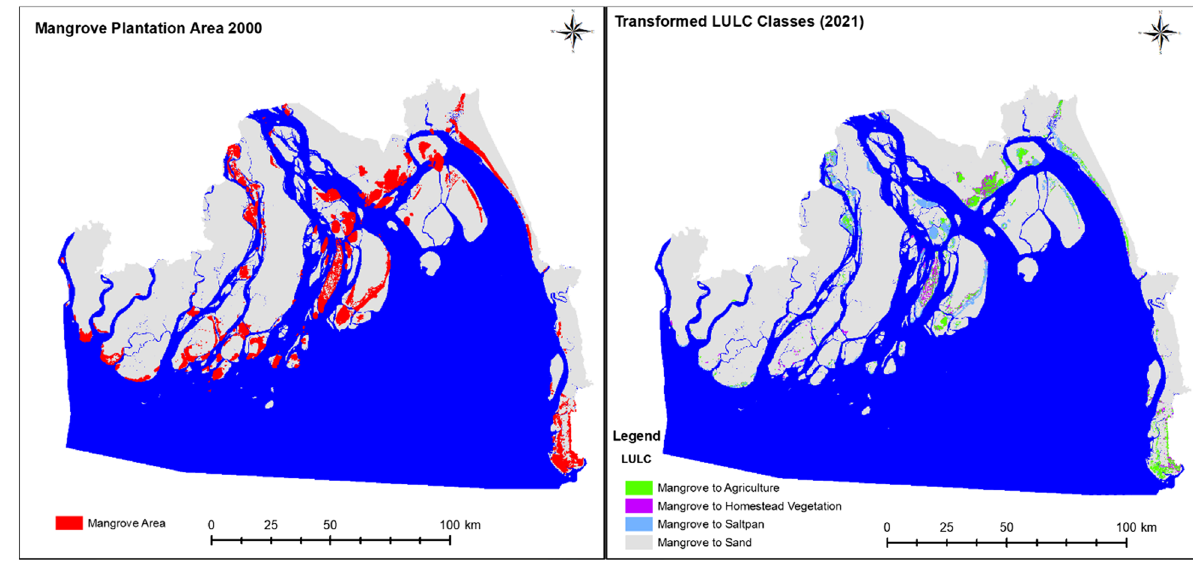
Fig. 17 Transformation of mangrove forest into other LULC categories